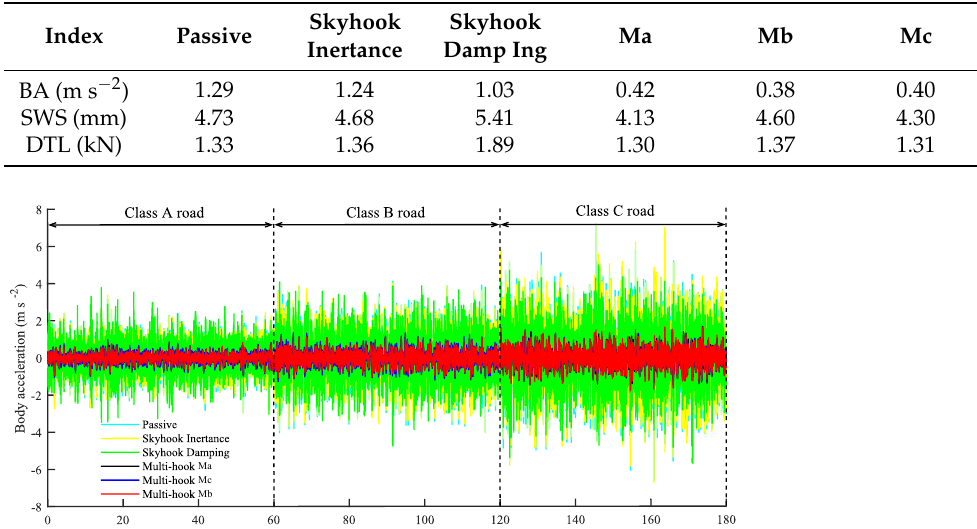
Table 9. Total RMS values under different road conditions for time response